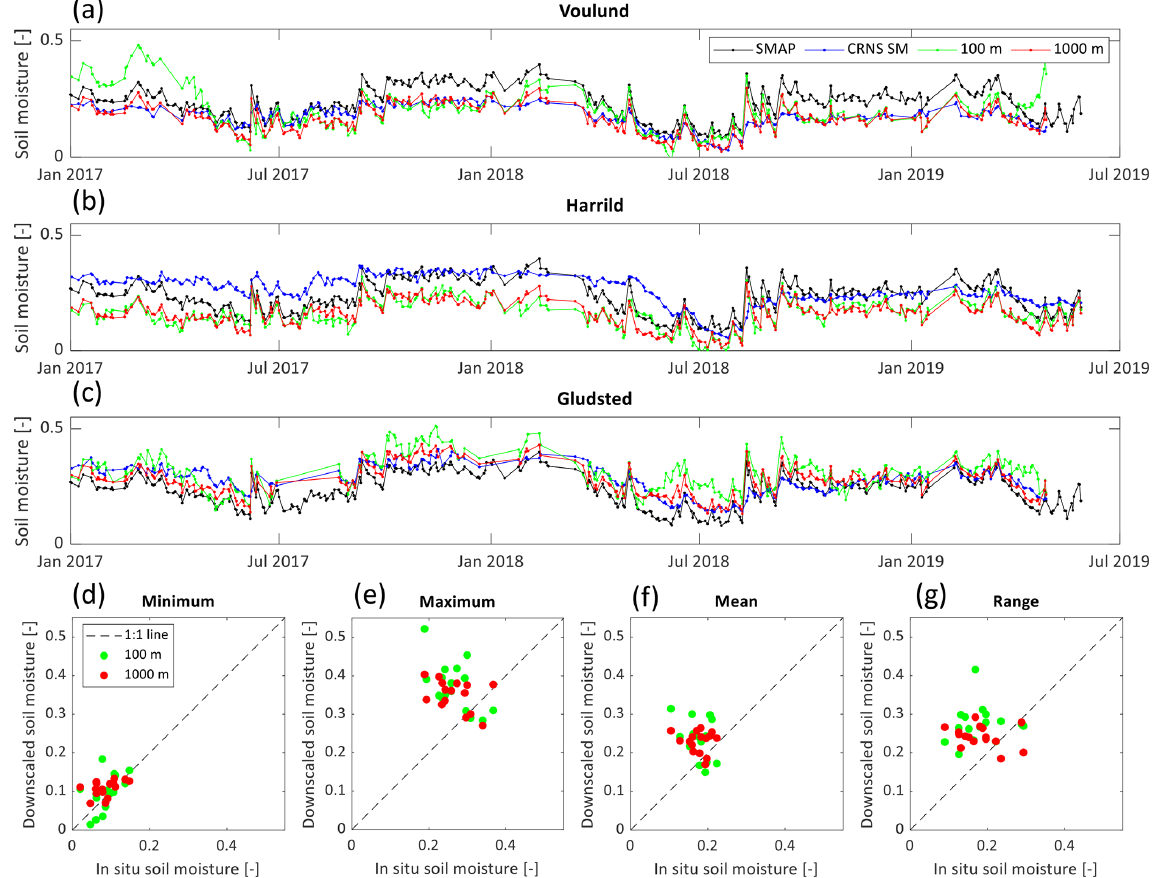
Figure 10. (a–c) Temporal dynamics of SMAP soil moisture (black line, averaged over the 21 pixels), in situ soil moisture (blue line, CRNS) and downscaled soil moisture (type 8) at 100m (green line) and 1000m (red line) spatial resolution at the three different CRNS sites at Voulund (agriculture), Harrild (heathland) and Gludsted (forest). (d–g) Scatter plot of minimum, maximum, mean and range of downscaled soil moisture at 100m (green dots) and 1000m (red dots) spatial resolution versus in situ soil moisture by capacitance probes.